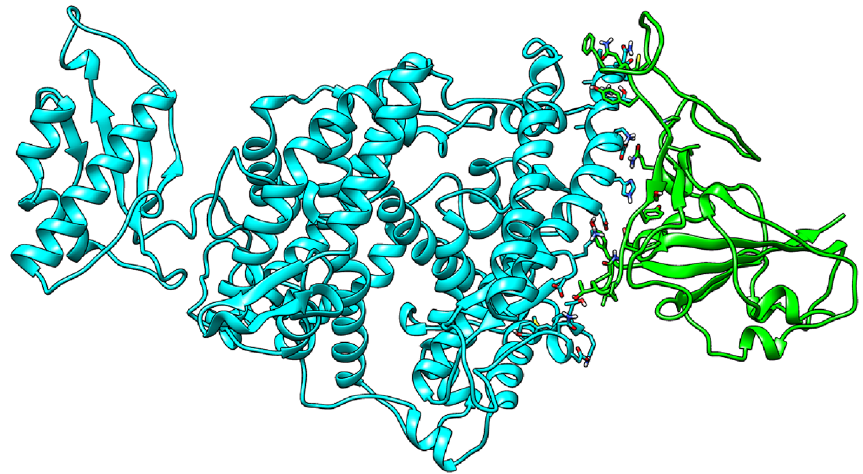
Figure 4. Spike–ACE2 protein interactions.